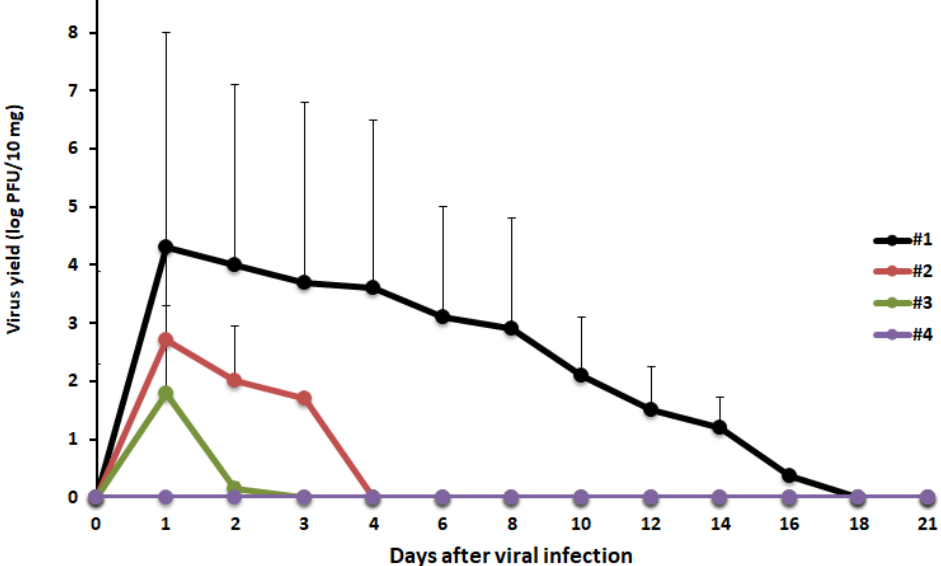
Figure 3. In vivo irreversibility of the virucidal effect of GSE. MNV (1 × 10 6 PFU/mouse) was treated with PBS (#1), GSE at 10 µ g/mL for 10 min (#2), GSE at 10 µ g/mL for 30 min (#3), or GSE at 50 µ g/mL for 10 min (#4) prior to oral administration to mice (n = 5). Mouse stool samples were monitored for infectious viral titers for 21 days.